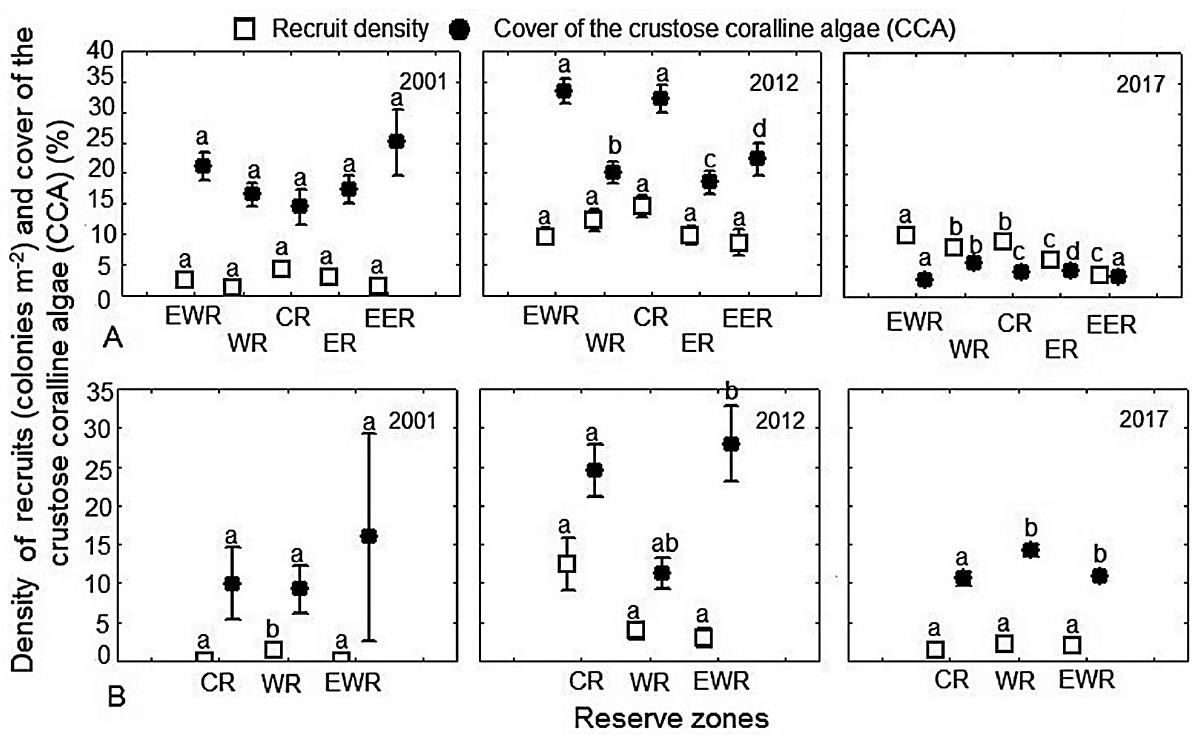
Fig. 8. – Recruit density (colonies m –2 ) and cover of crustose coralline algae on the fore reef (A) and reef crests (B) (EWR, Westernmost Reserve; WR, Western Reserve; CZ, Central Reserve; ER, Eastern Reserve and EER, Easternmost Reserve). A. 2001: recruit (df=4, p-value=0.05659), cover (df= 4, p-value=0.06401). 2012: recruit (df=4, p-value=0.3086), cover (df=4, p-value=3.173e-09). 2017: recruit (df=4, p-value=1.668e-12), cover (df=4, p-value=3.232e-06). B. 2001: recruit (df=2, p-value=0.02439), cover (df=2, p-value=0.6849). 2012: recruit (df=2, p-value=0.09995), cover (df=2, p-value=1.302e-06). 2017: recruit (df=2, p-value=0.2069), cover (df=2,